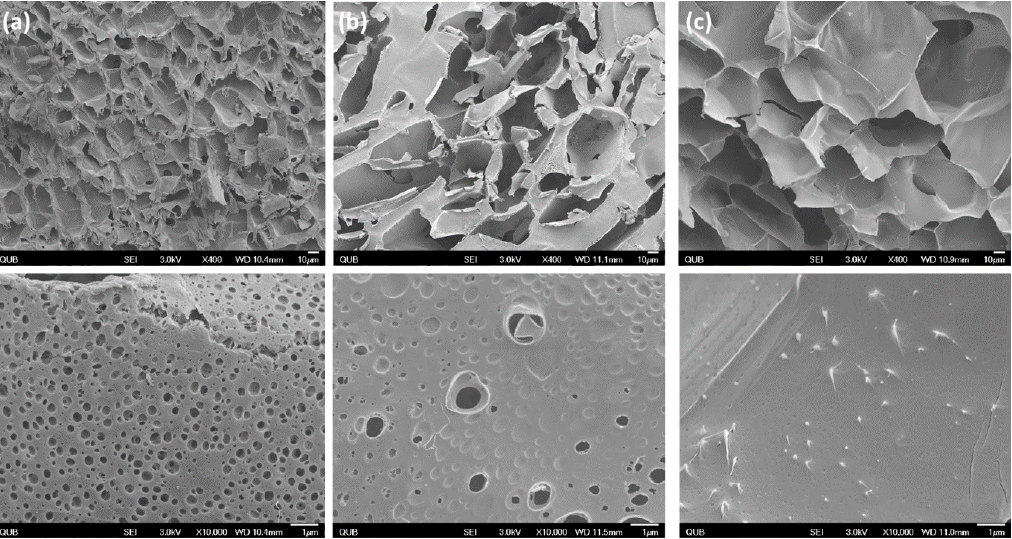
Figure 6. SEM of hydrogel at ×400 (above) and ×10,000 (below): ( a ) Cs-g-PNIPAAm hydrogel, ( b ) Cs-g-PNIPAAm hydrogel with pure HA and, ( c ) Cs-g-PNIPAAm hydrogel with RALA-HA NPs.